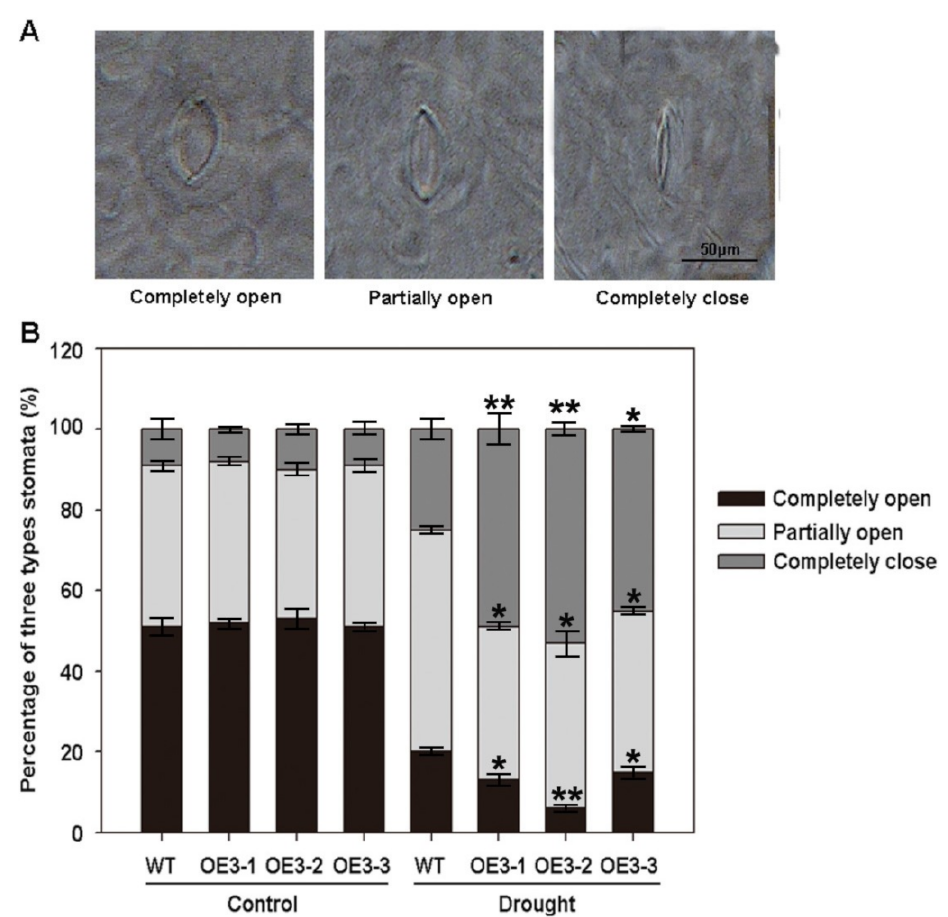
Figure 6. Overexpression of ZmASR3 increases stomatal closure. ( A ) Observation of stomatal closure in transgenic Arabidopsis and WT plant leaves. Scale bar = 50 µ m. ( B ) The percentage of completely open, partially open, and completely closed stomata were analyzed in the leaves of ZmASR3 transgenic Arabidopsis and WT plants under normal conditions and drought stress (200 stomata were analyzed for each line). Vertical bars indicate means ± S.E. ( n ≥ 3). Significant di ff erences: * p < 0.05; ** p < 0.01. Scale bar = 50 µ